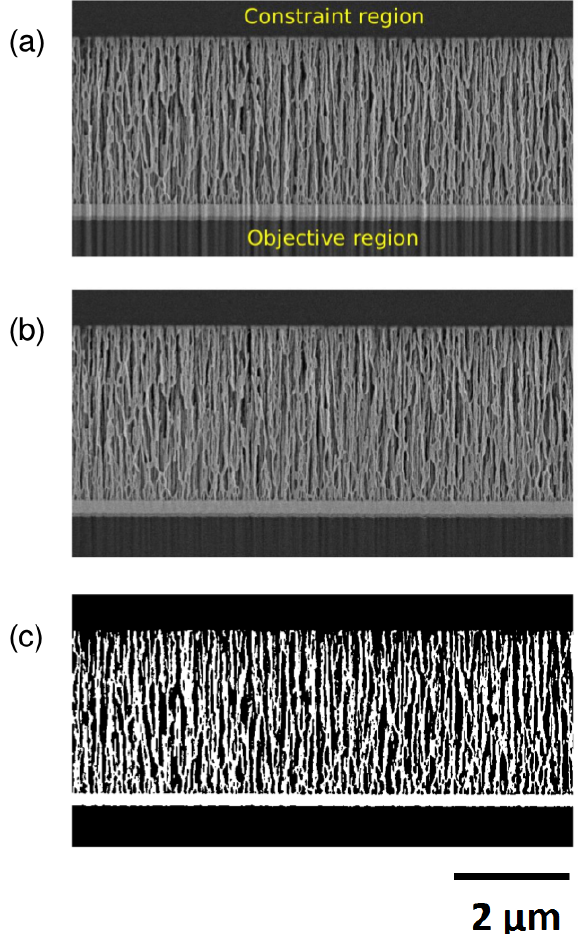
Figure 4. Decurtaining of Ta80. A slice from the original Ta80 sam- ple showing the objective and constraint regions (a) . The slice after the decurtaining algorithm (b) and binarization (c)